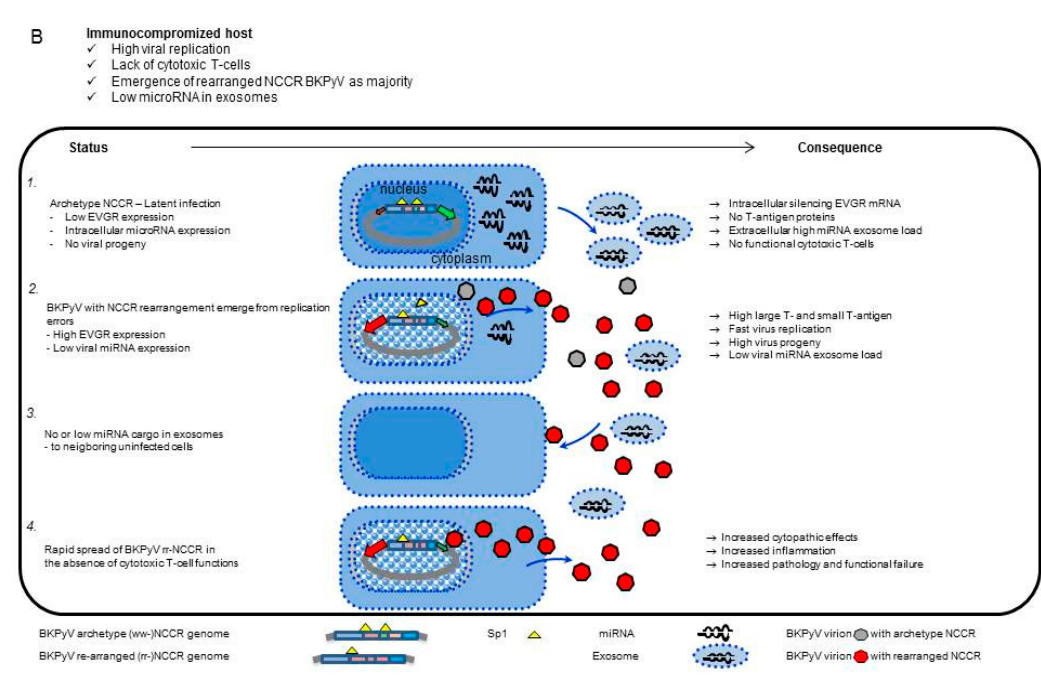
Figure 8. Model of BKPyV miRNAs expression and exosome traffic. ( A ) Immunocompetent host:1- Archetype NCCR-BKPyV establishes latent infection with low EVGR expression and strong silencing by high-level miRNA expression; 2- Displacement of Sp1 from SP1-4 through host cell activation permits activation of EVGR expression and lowering of miRNA expression; 3- Exosomes deliver BKPyV miRNA cargo to uninfected cells; 4- Subsequent infection with archetype BKPyV counteract new rounds of viral replication, thereby avoid recognition by cytotoxic T-cells. ( B ) Immunocompromised host: 1- Status and consequences during BKPyV archetype persistent infection; 2- BKPyV with rearranged NCCR emerge in immunocompromised patients as the immune selection pressure fades; 3- No or low miRNA cargo in exosome delivery to uninfected neighbouring cells; 4- Rapid spread, increased cytopathology and functional failure. Supplementary Materials: The following are available online at www.mdpi.com/xxx/s1, Figure S1: Size, concentration and markers of Cos-7 exosome enriched vesicles., Figure S2: Cells adsorption and penetration of exosomes enriched vesicles containing BKPyV miRNAs.